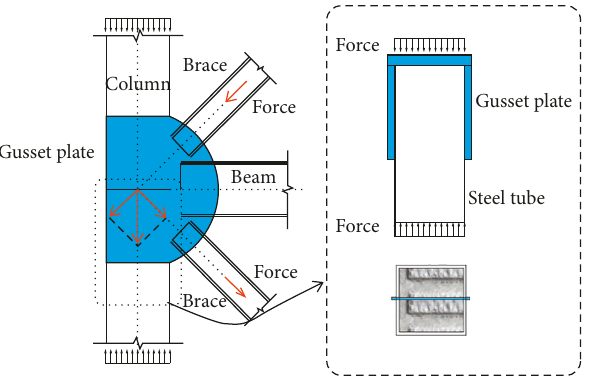
Figure 1: Simple CFT connection in